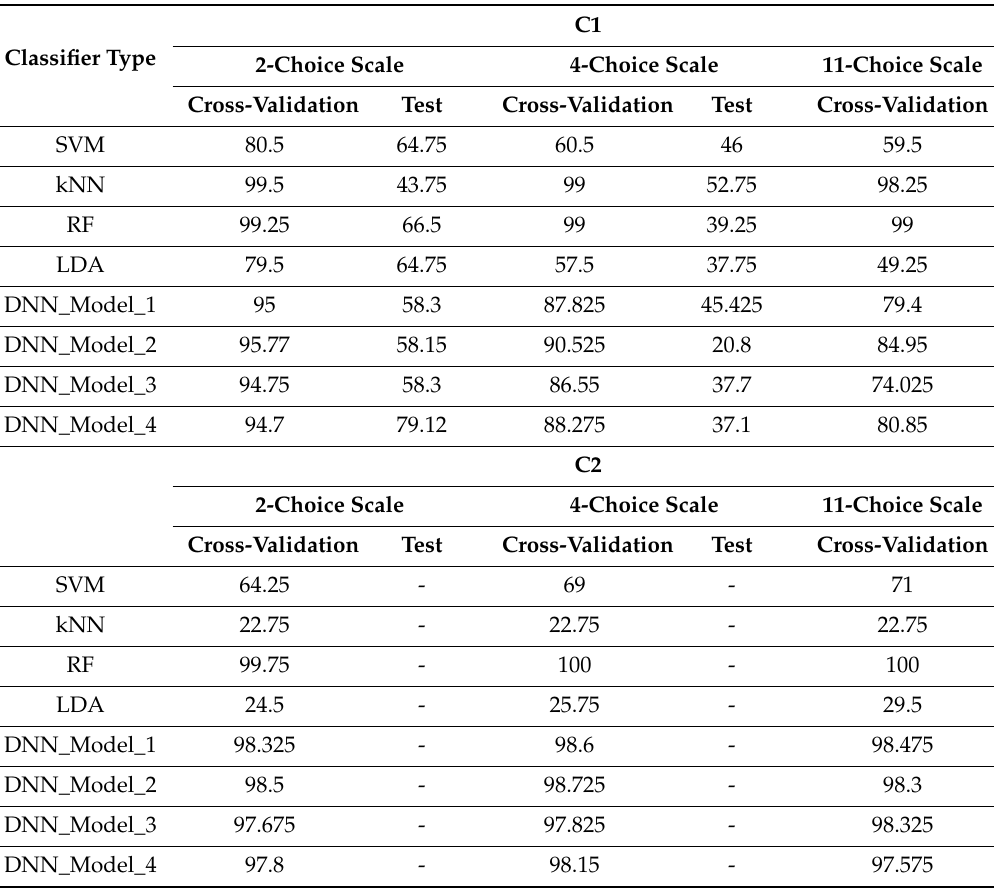
Maximum cross-validation accuracy and test (validation) accuracy (in %) for the player-independent modality, without SFS feature